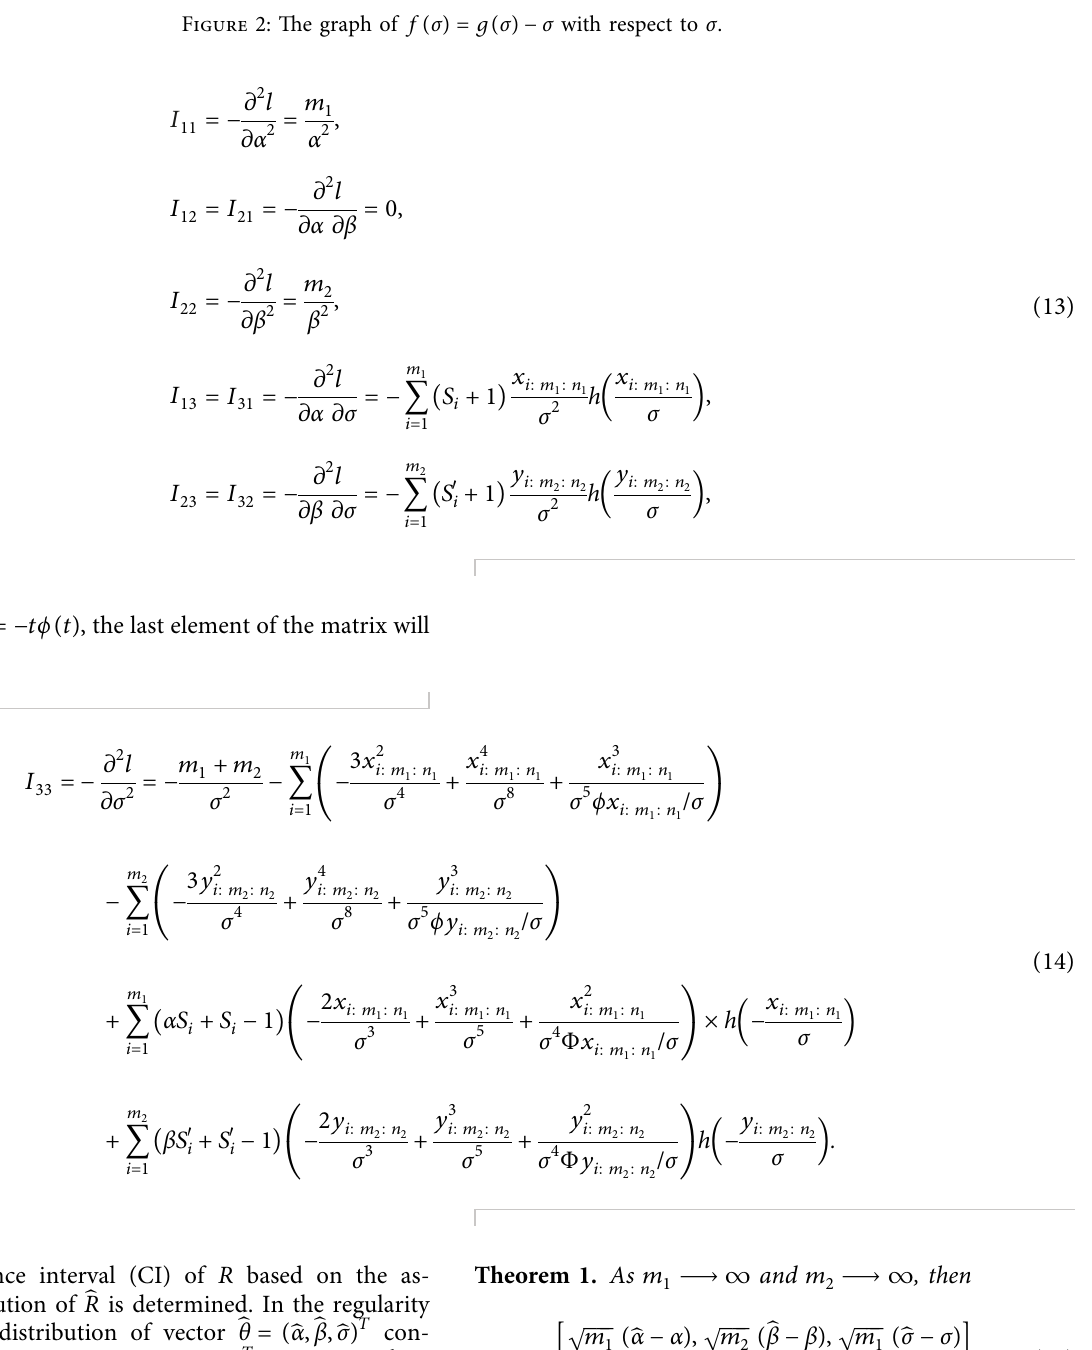
Figure 2: The graph of f